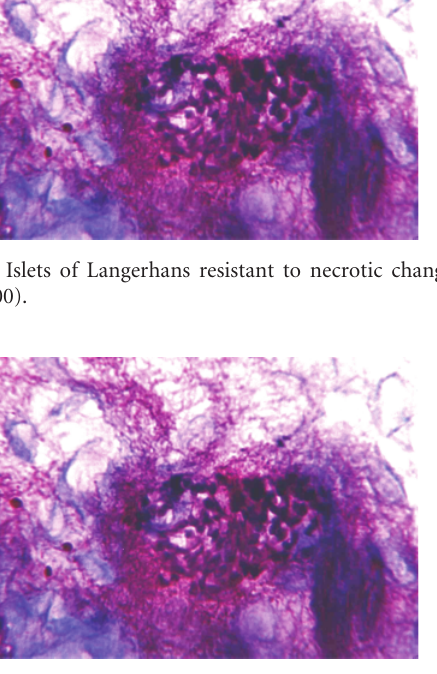
Figure 10: Fibrin masses noted around Langerhans islet in the zone of necrosis. Masson staining ( × 100). Table 1: Early, late, and protective changes in pancreatic tissue in patients with